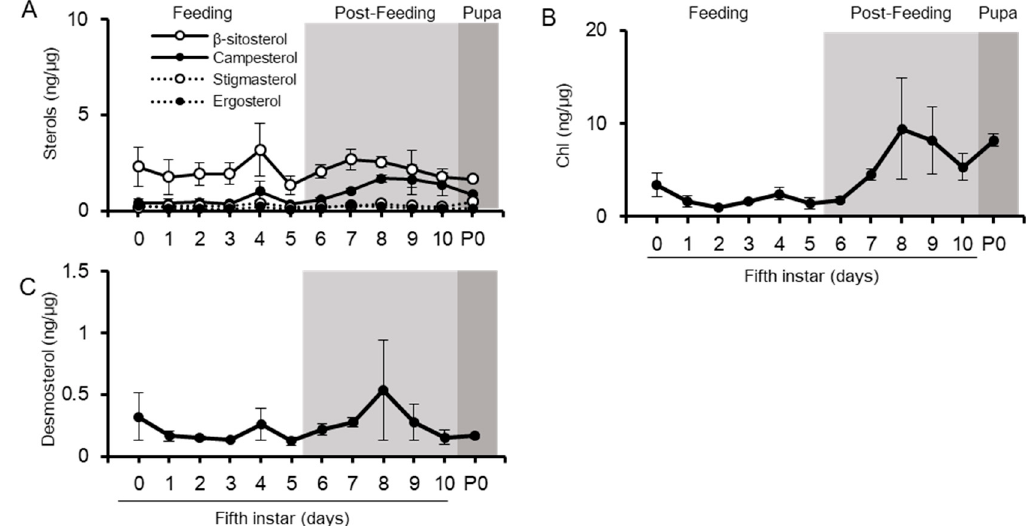
Figure 2. Changes in sterol amounts in the midgut from final instar to pupal periods. The amount of dietary sterols ( A ), Chl ( B ), and desmosterol ( C ) was quantified using LC-MS / MS and standardized using the protein amounts of the respective samples. Values are mean ± s.d. ( n = 3). P0: pupal stage day 0.